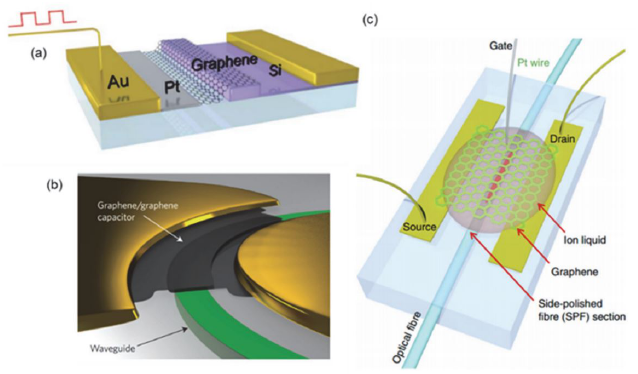
Figure 10. A wave-guide based optical modulator. ( a ) graphene is integrated on silicon wave-guide.; ( b ) graphene is integrated on ring resonator; ( c ) graphene is integrated on fiber optic wave guide. Reprinted with permission from [53,56,57]. Copyright (2015, 2011) Nature Publishing